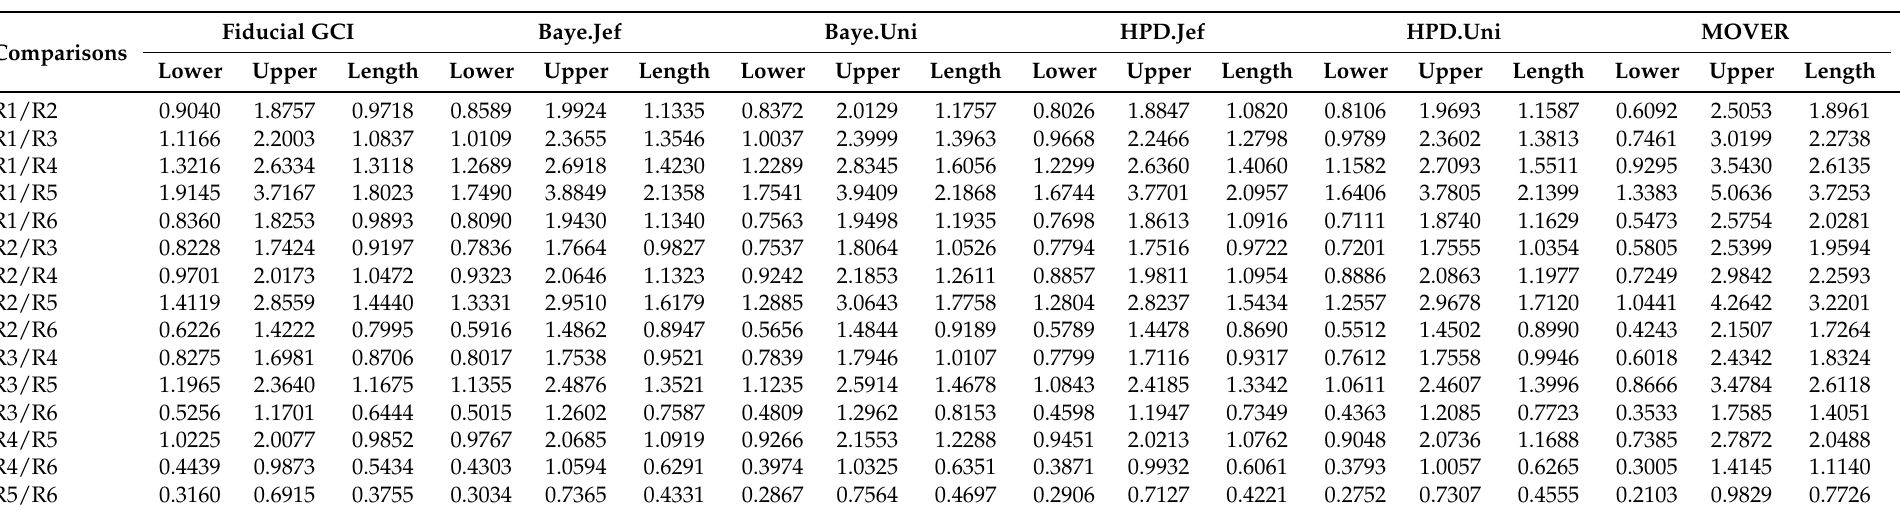
Table 8. The ratios of the means of the daily rainfall datasets for September 2021 from six regions in Thailand with nominal 95% simultaneous